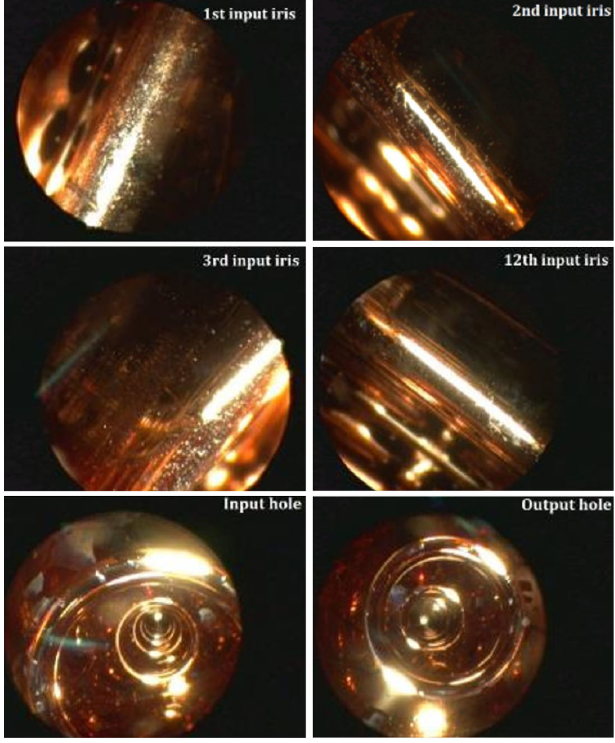
FIG. 18. Borescopy images from the structure after condition- ing: the iris of the first, second (top), third, and twelfth (middle) cells, one of the coupling holes of input and output cells